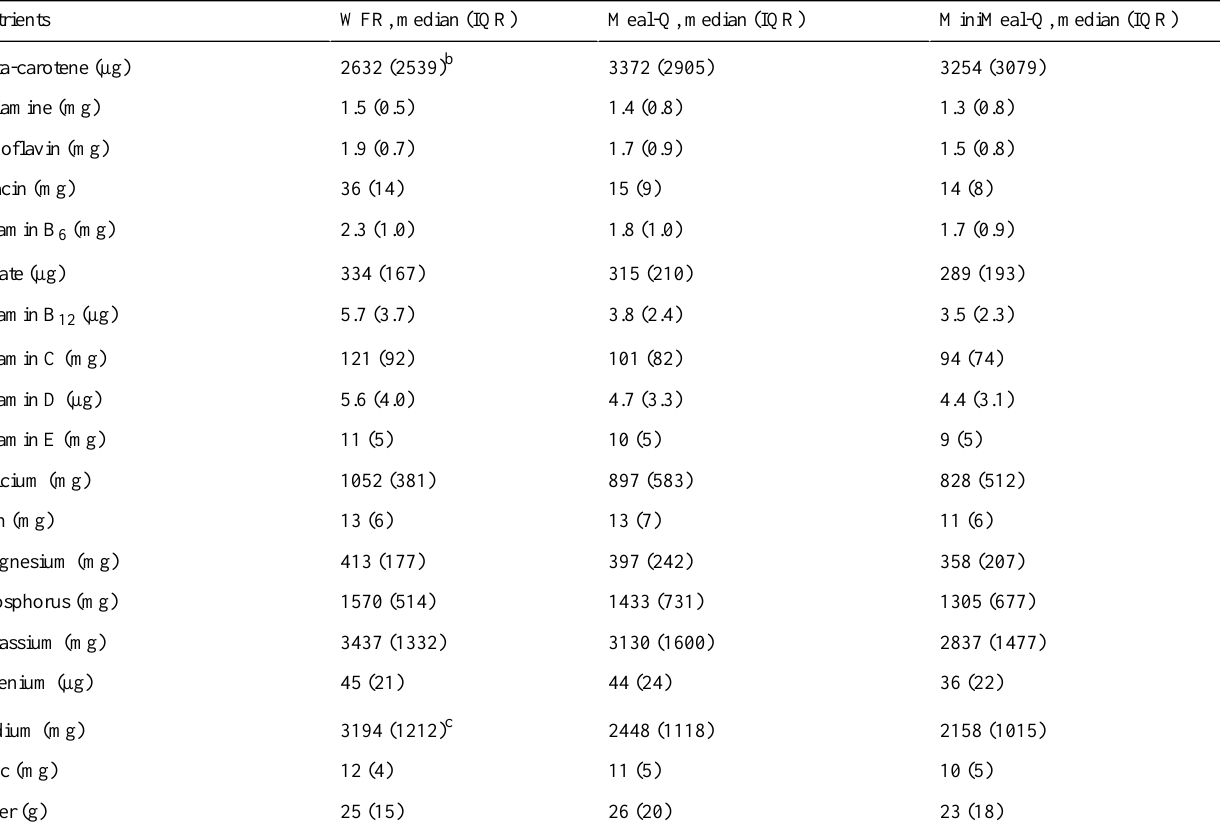
Table 2. Median (IQR) daily crude micronutrient and fiber intake a assessed with the weighed food record (WFR), Meal-Q, and MiniMeal-Q